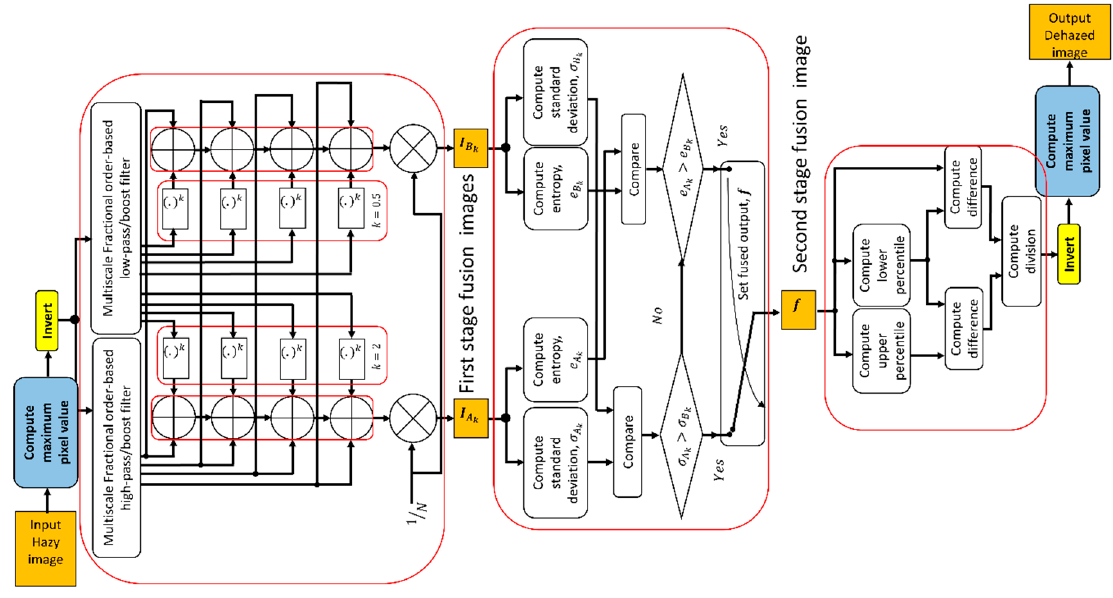
Figure 1. Proposed algorithm (PA) for enhancing hazy and underwater images.